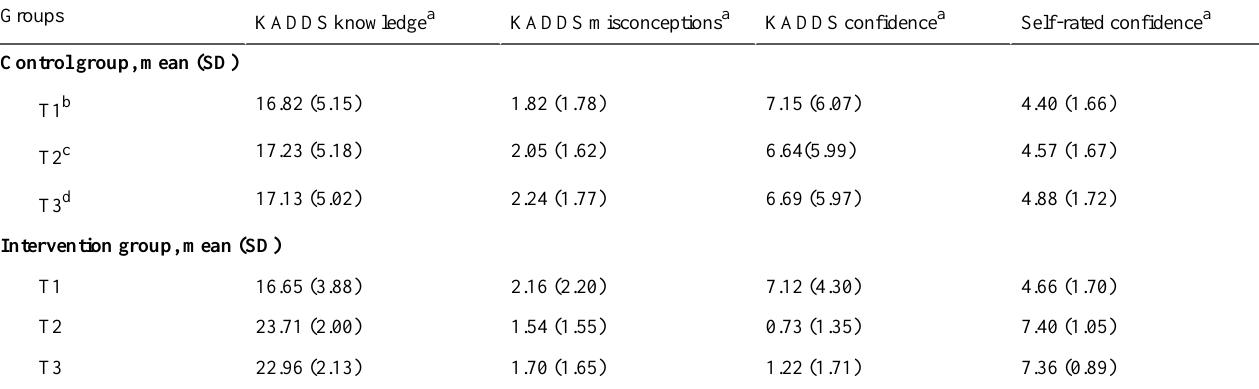
Table 2. Descriptive statistics of the knowledge, misconceptions, and confidence scores of the Knowledge of Attention Deficit Disorders Scale (KADDS) for the 2 groups at the 3 different time